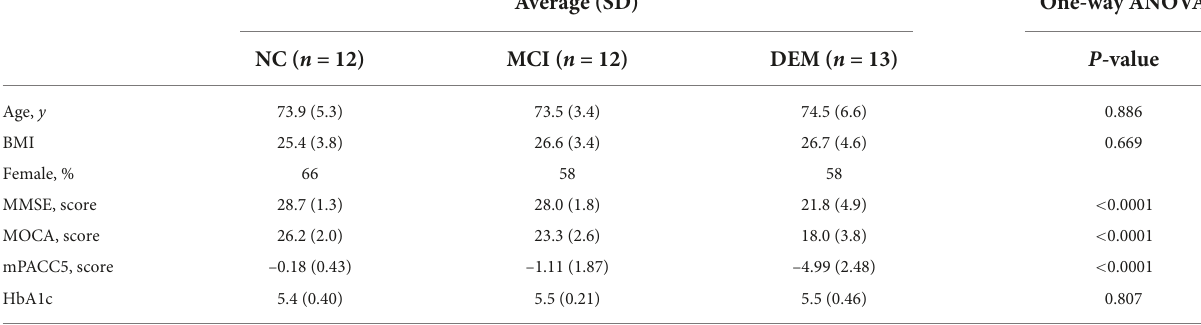
TABLE 1 Demographics and cognitive scores for discovery